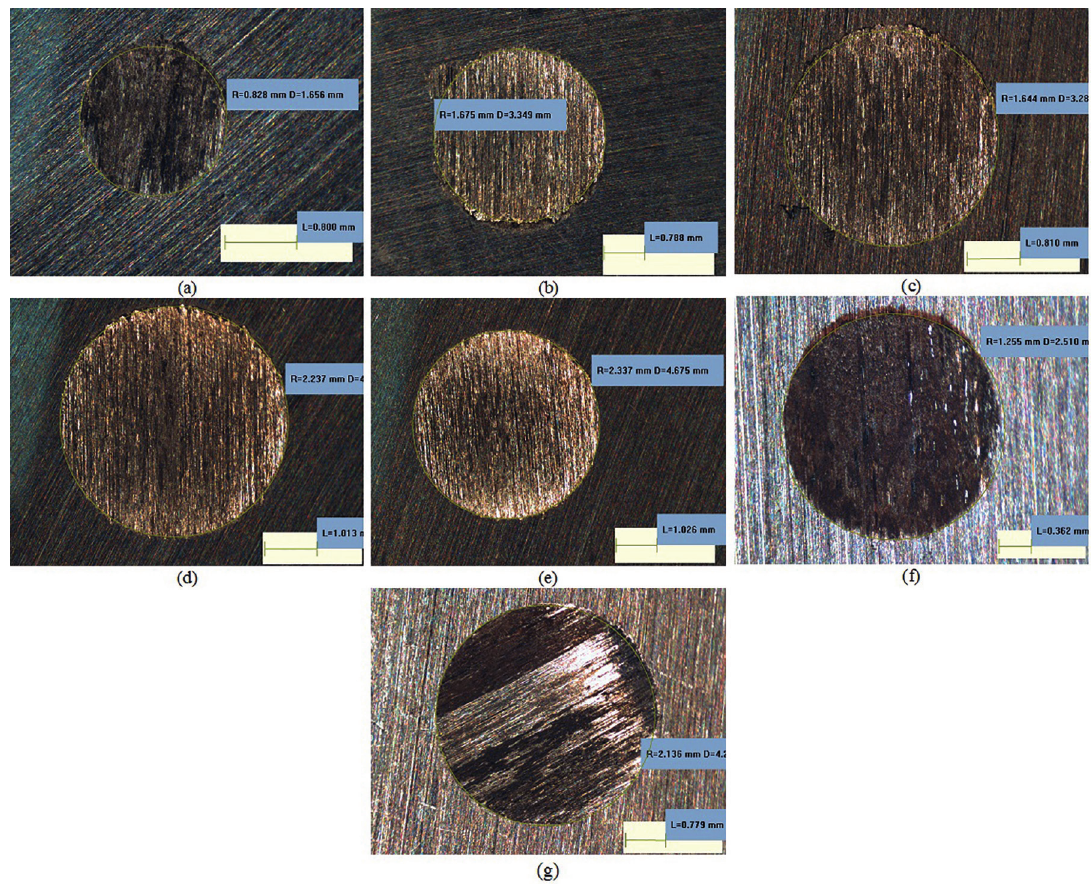
Figure 5: Caps produced in the microwear test for different sliding distances under an 8.3-N load at (A) 2 minutes, (B) 5 minutes, (C) 10 minutes, (D) 15 minutes, (E) 20 minutes, (F) 30 minutes and (G) 40 minutes.